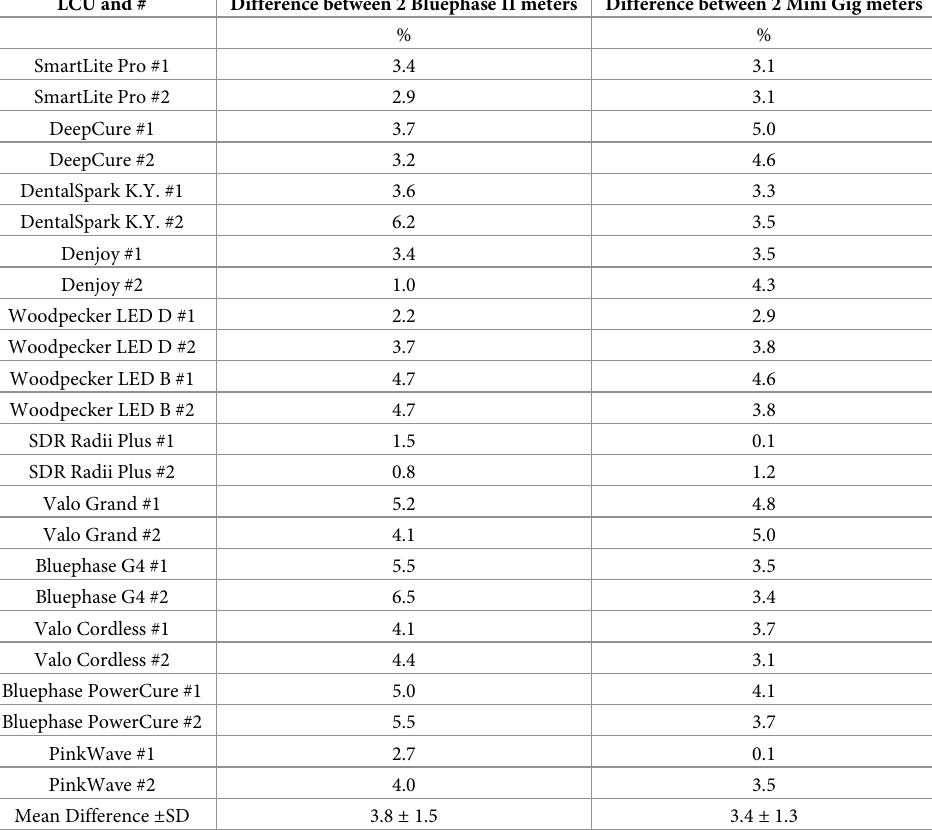
Table 5. Percentage differences between the power values from each LCU (units #1 and #2) recorded using the two Bluephase Meter II and Mini Gig radiometers. LCU and # Difference between 2 Bluephase II meters